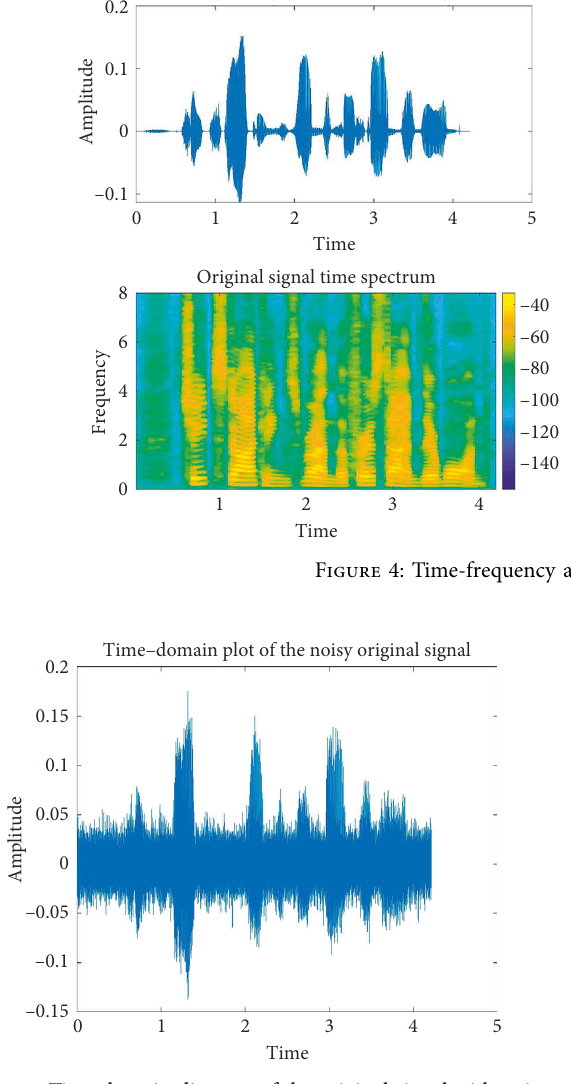
Figure 5: Time domain diagram of the original signal with noise. Figure 6: NLM preprocessing result of noisy signal.